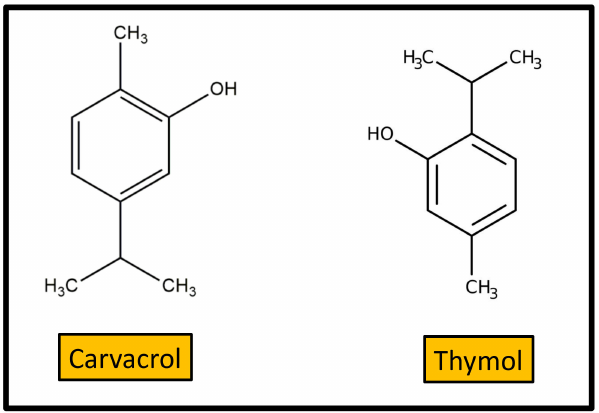
Figure 6. Structure of carvacrol and its isomer